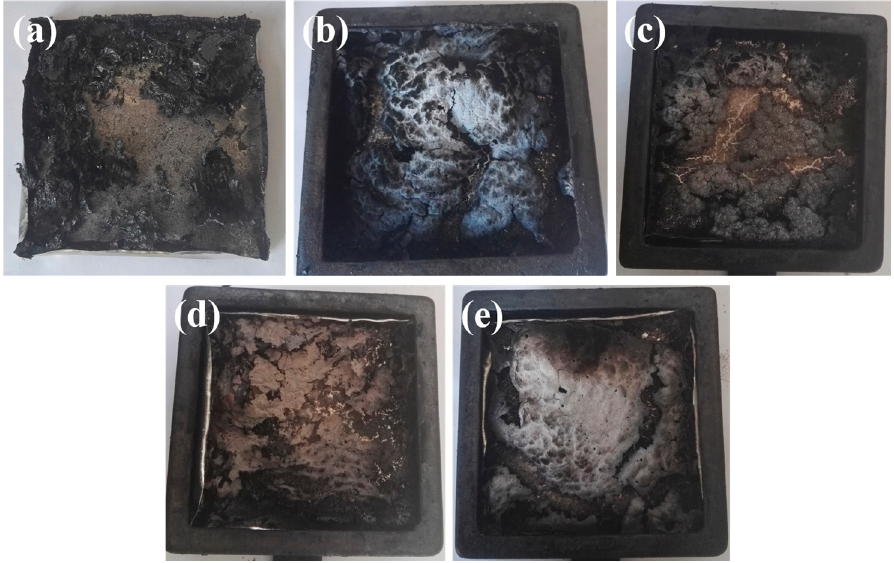
Figure 6. Digital photographs of ( a ) TPU; ( b ) TPU/CAHPi5; ( c ) TPU/CAHPi10; ( d ) TPU/CAHPi20 and; ( e ) TPU/AHPi after the cone calorimeter test.